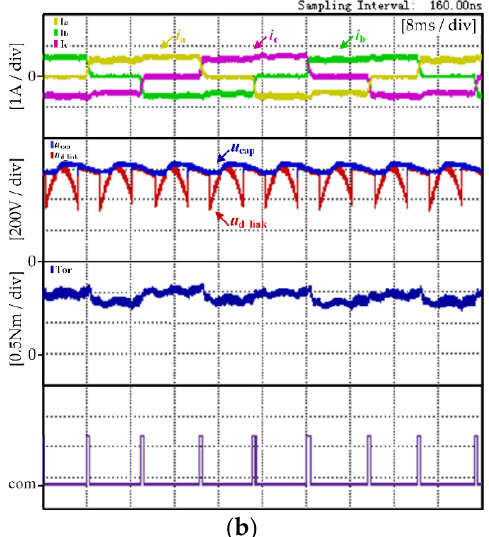
Figure 11. Experimental results under the low speed condition (200 r/min, 0.89 N · m): ( a ) traditional strategy ( b ) proposed strategy.